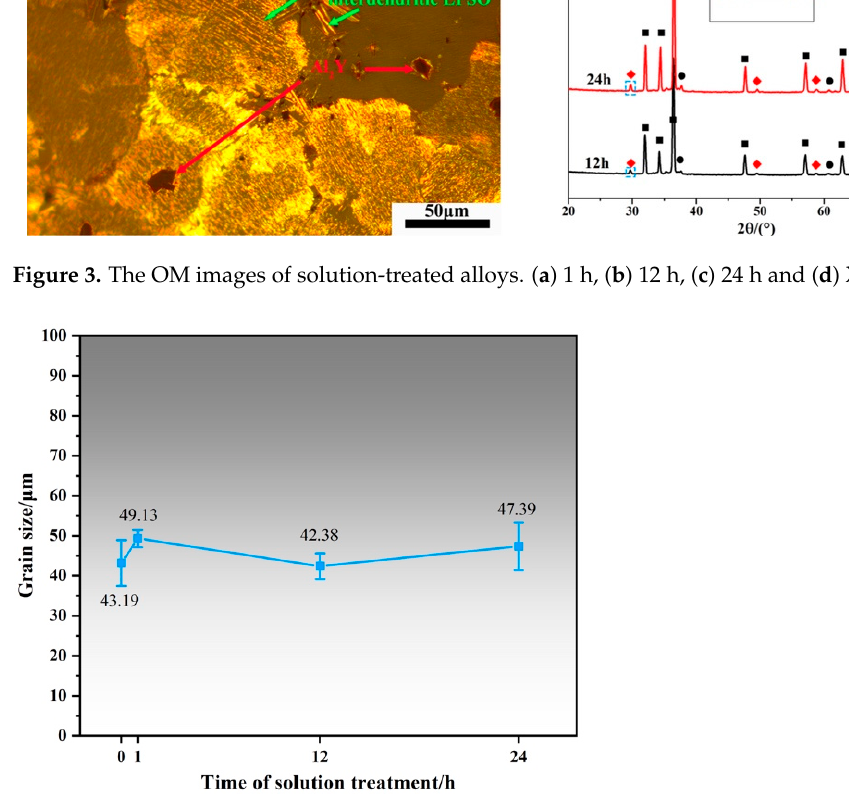
Figure 4. Grain size line chart of as ‐ cast alloy and solid solution alloy.